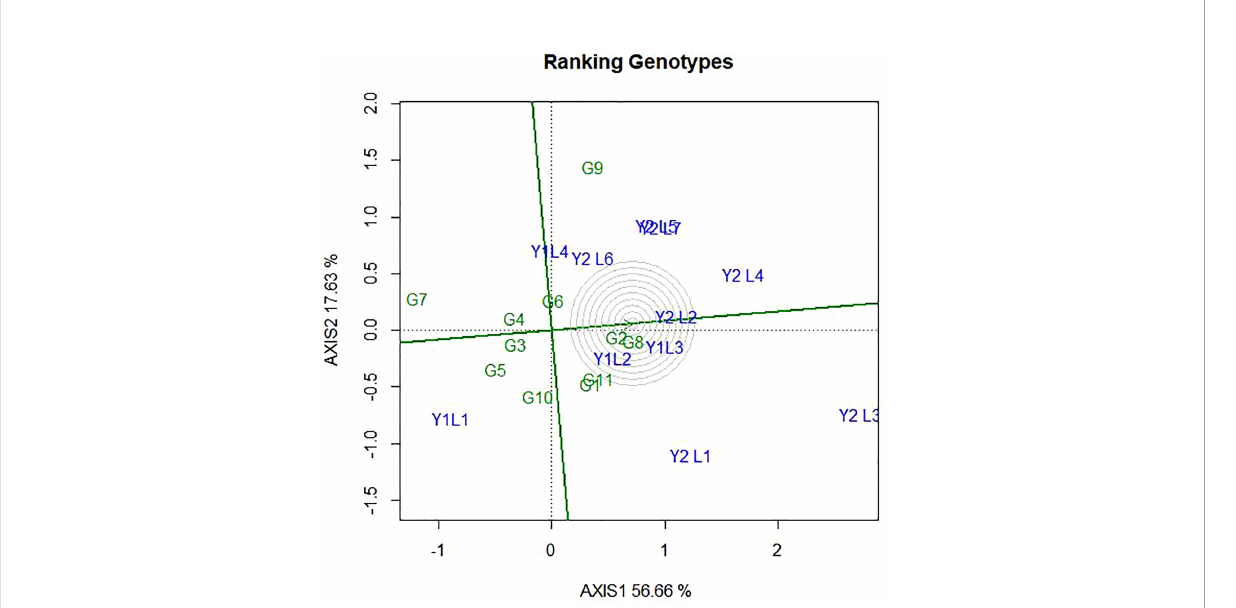
FIGURE 8 The GGE biplot ‘ Genotype ranking ’ pattern for environment comparison with ideal environment showing G + G × E interaction effect of 11 soybean genotypes under two years (11environemnets) for grain yield per hectare. The biplots were created based on Centering = 0, SVP = 2, Scaling = 0.